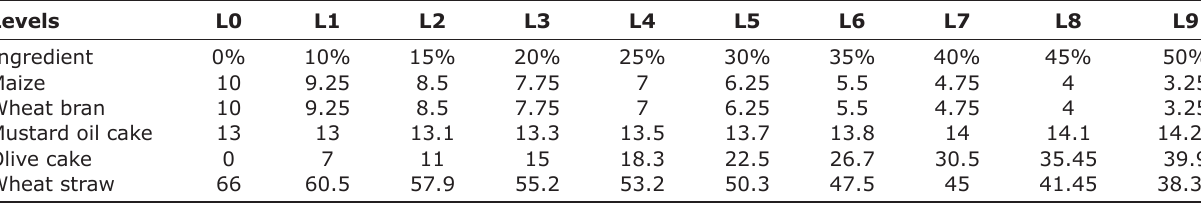
Table-1: Inclusion levels of lime treated Indian olive cake on ADF replacement levels* Levels L0 Ingredient